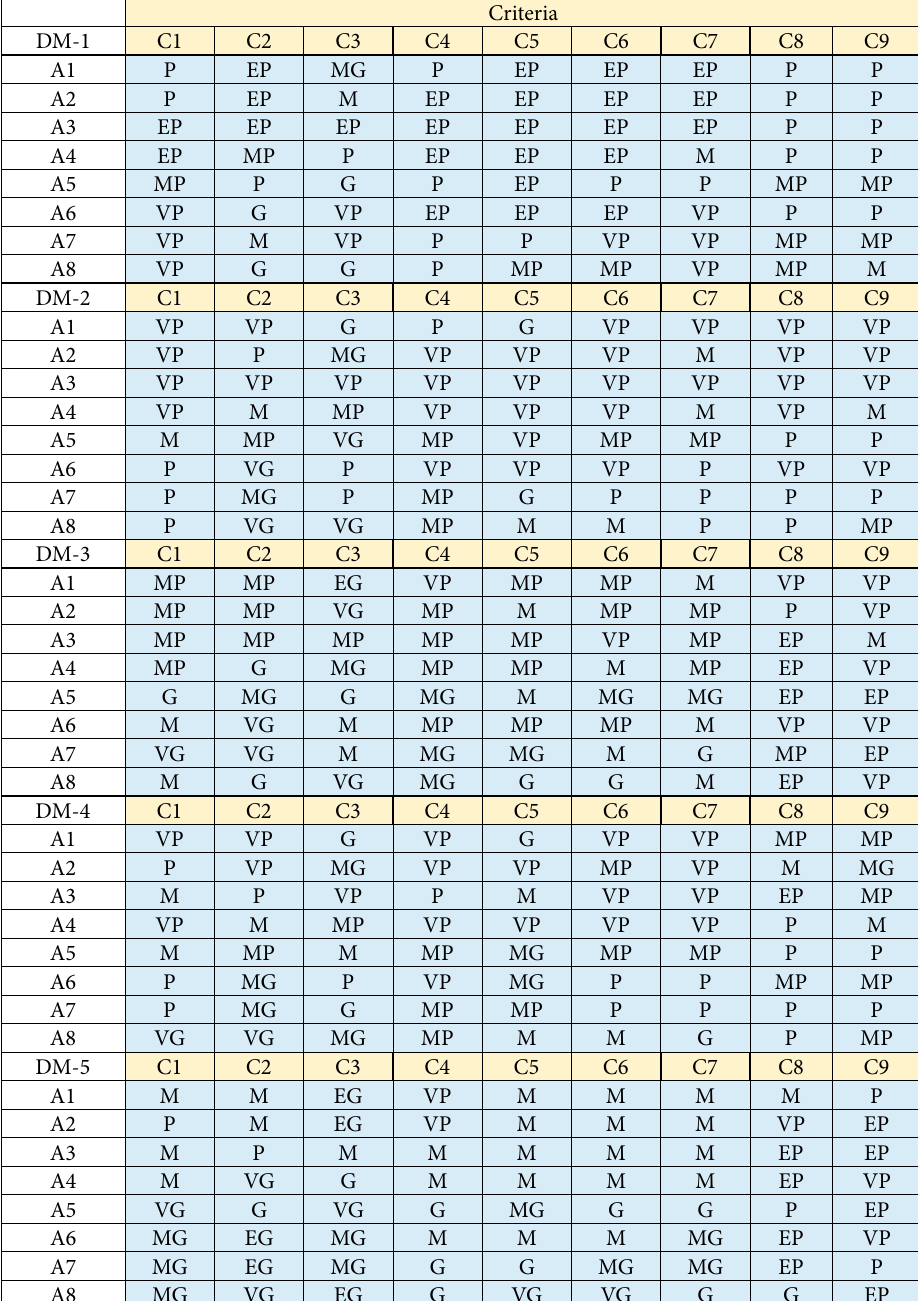
Table A1. DMs’ linguistics evaluations for decision alternatives